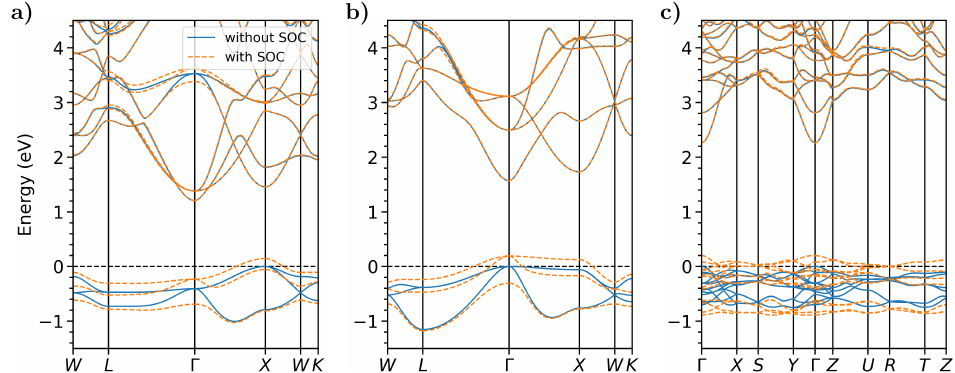
Figure 4. Electronic band structures of ( a ) Cs 3 Sb, ( b ) CsK 2 Sb, and ( c ) Cs 2 Te calculated from DFT (SCAN functional), with and without including spin-orbit coupling (blue solid lines and orange dashed lines, respectively). The energy range is offset with respect to the valence band maximum in the calculation without spin-orbit coupling. The data for Cs 3 Sb and Cs 2 Te coincide with those published in Reference